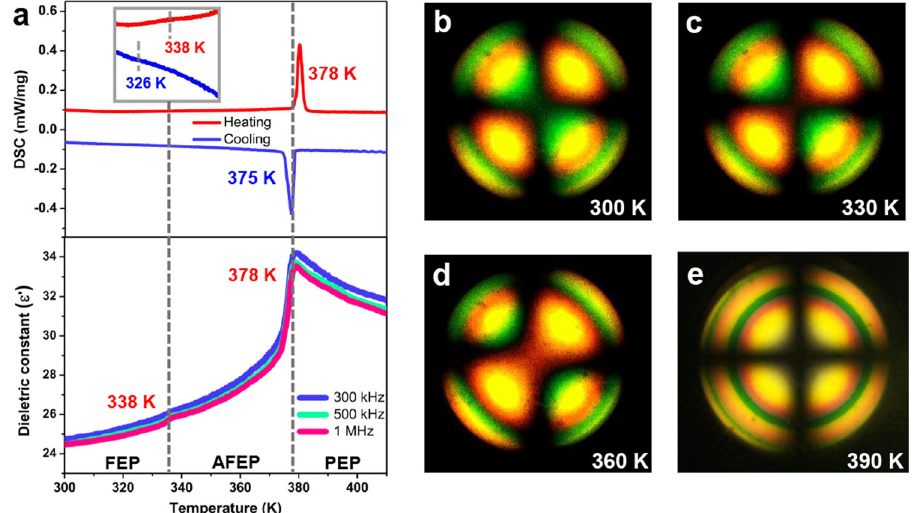
Fig. 1 | Phase transition behaviors of 1. a DSC curves recorded in the heating-cooling modes and temperature-dependent ε ʹ measurement along the c -axis at various frequencies. Conoscopic images of N B (optical biaxiality) and N D (optical uniaxiality) phases observed at b 300K, c 330K, d 360K and e 390K,